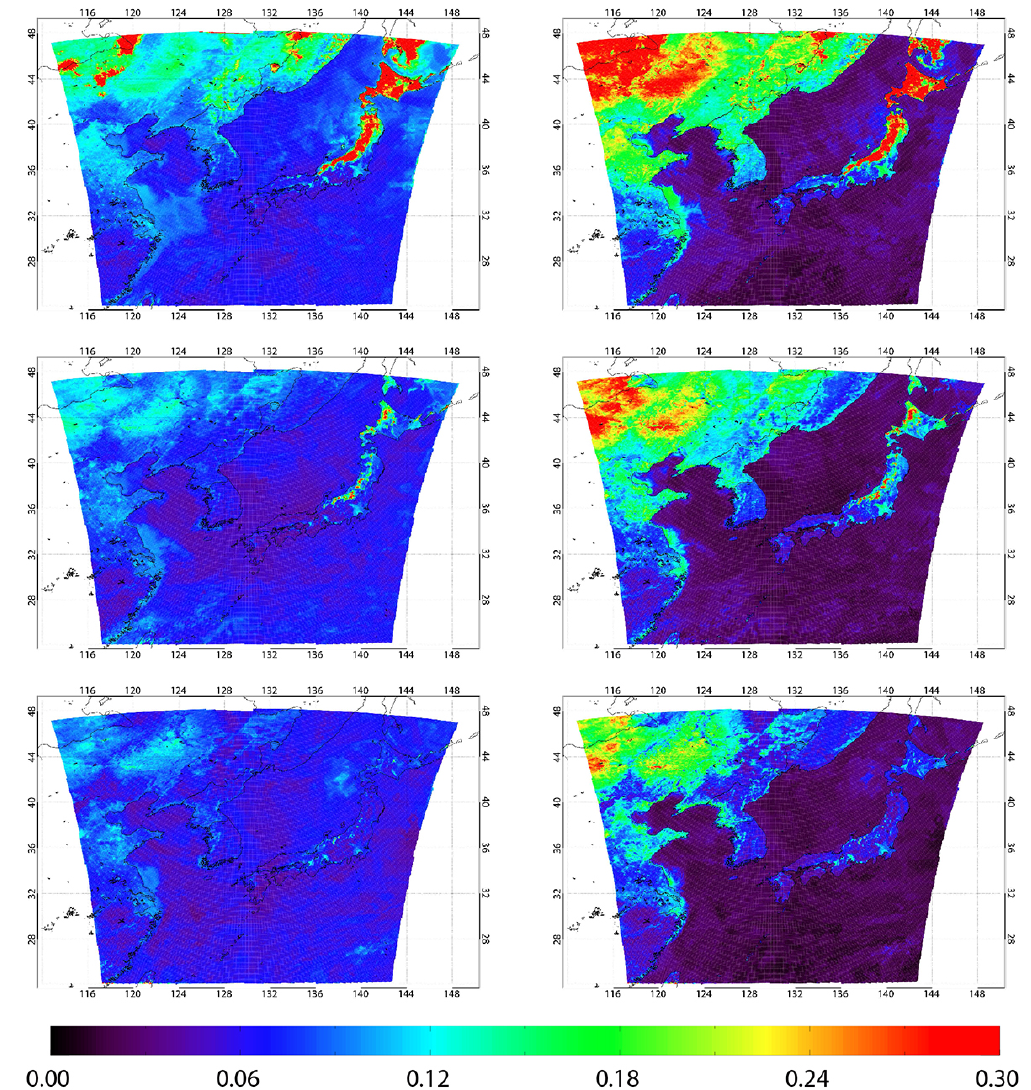
Figure 2. Surface reflectance on 15th of the month, 13:30 local standard time (LST) at 443nm (left column) and 660nm (right column): March (upper row), April (middle row), and May (lower